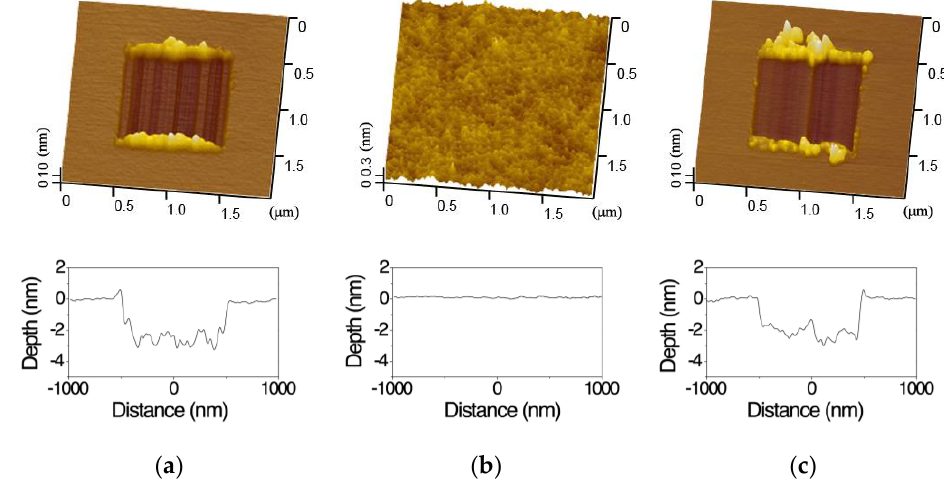
Figure 2. AFM images of wear scars on silicon surface at 60% RH and 90% RH. ( a ) First wear test at 60% RH; ( b ) second wear test at 90% RH; ( c ) third wear test at 60% RH. F n = 3 μN, N = 2, A = 1 μm × 1 μm, v = 4 μm/s.